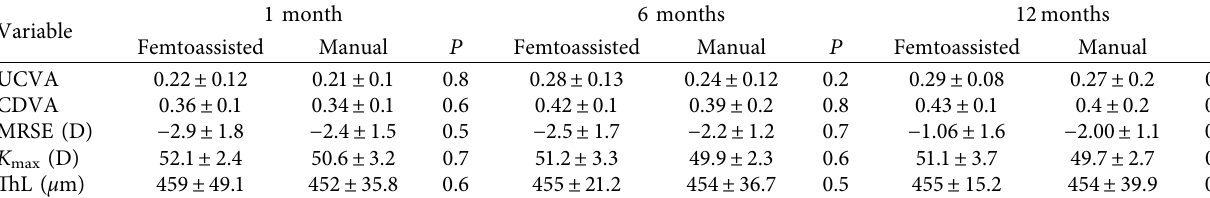
Table 2: Postoperative outcomes of both groups at follow-up visits.